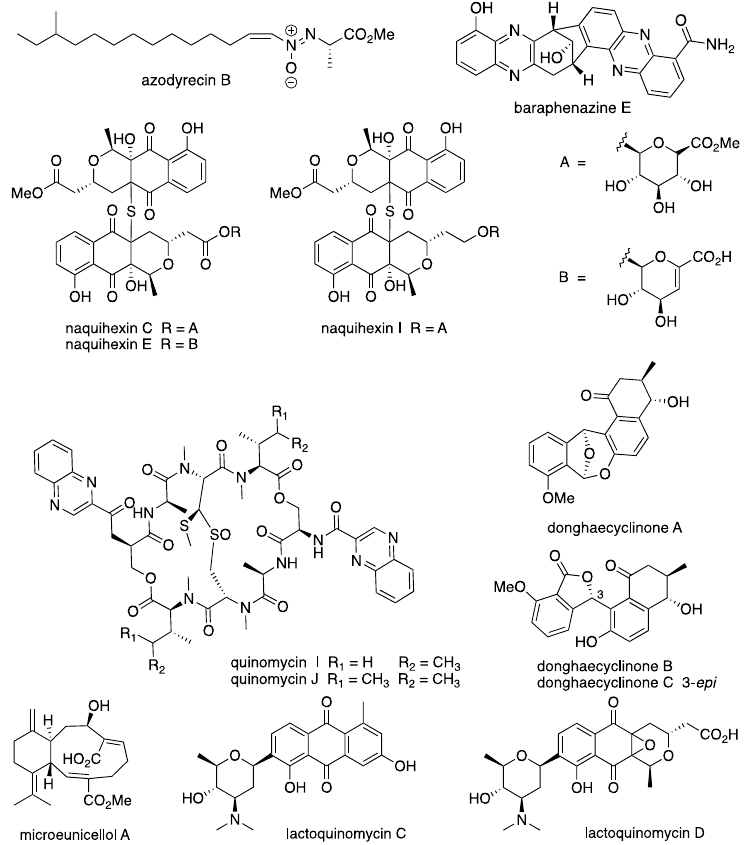
Figure 6. Examples of new compounds isolated from Streptomyces spp. between 2015 and 2020 with anticancer activity.